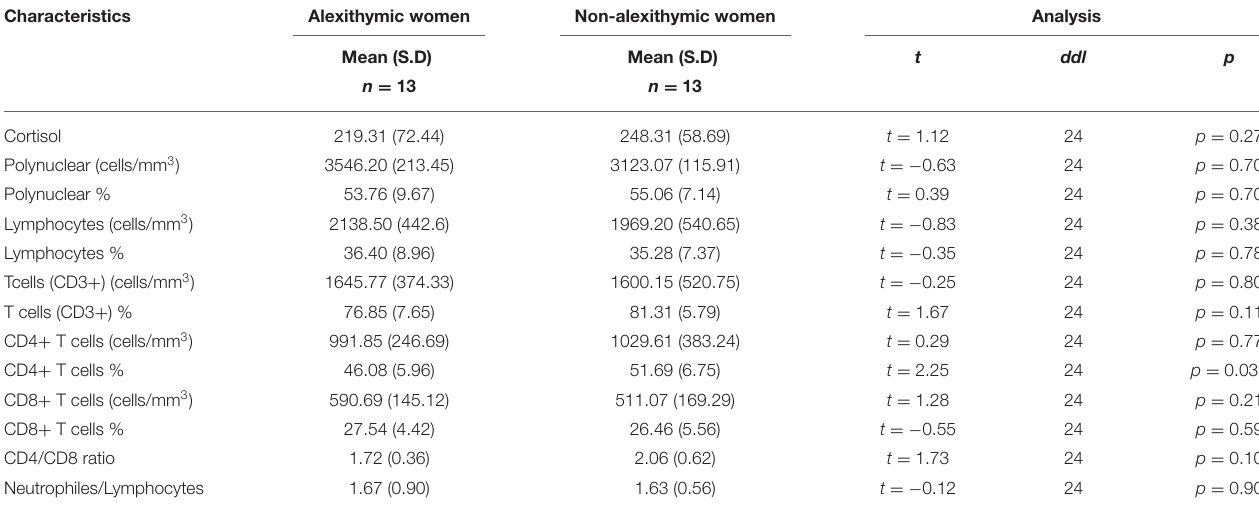
TABLE 2 | Immunological characteristics and serum levels of cortisol of alexithymic women vs. non-alexithymic women who were recalled and included (1-year later).